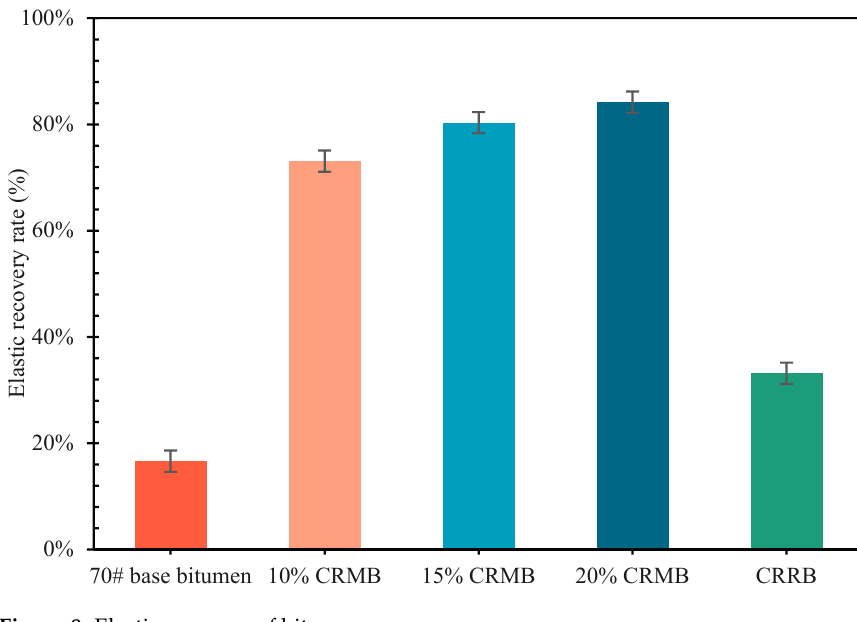
Figure 8. Elastic recovery of bitumen.